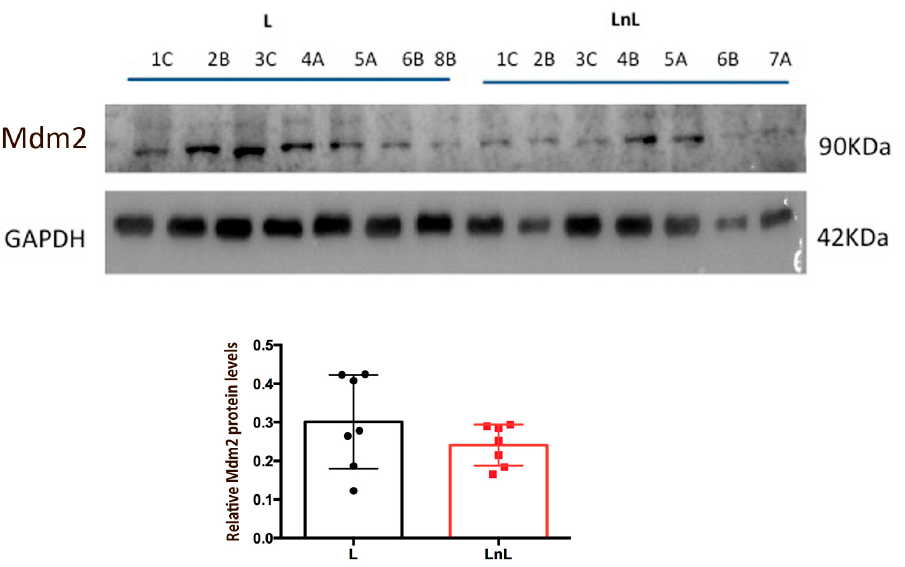
Figure 6. Lower Mdm2 levels in LnL mice. ( Top ) WB analysis of indicated protein levels in muscles derived from animals of L and LnL groups, GAPDH was used as loading control. ( Bottom ) Graphs reporting densitometric analysis of Mdm2 relative to GAPDH levels (mean ± SD) in indicated groups (n.s., two-tailed unpaired t-test, n = 7/group).